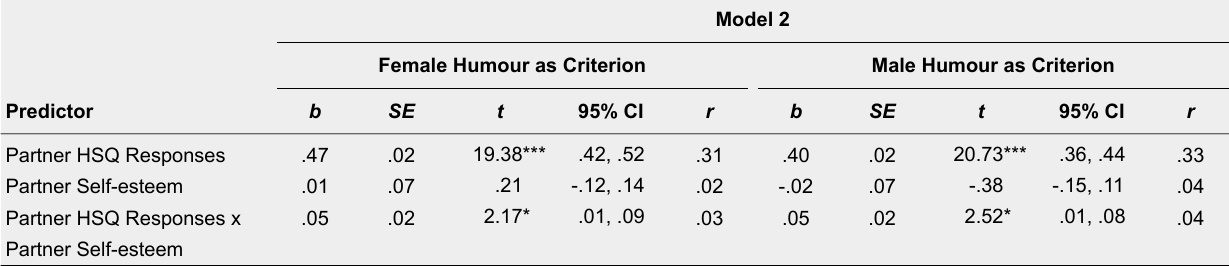
Multilevel Models Testing the Effects of One Partners’ HSQ and Self-Esteem Predicting the Other Partners’ HSQ Responses (Model 2)